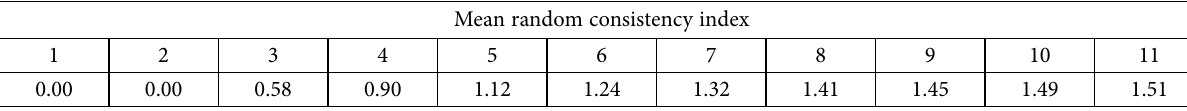
Table 11. Mean random consistency index